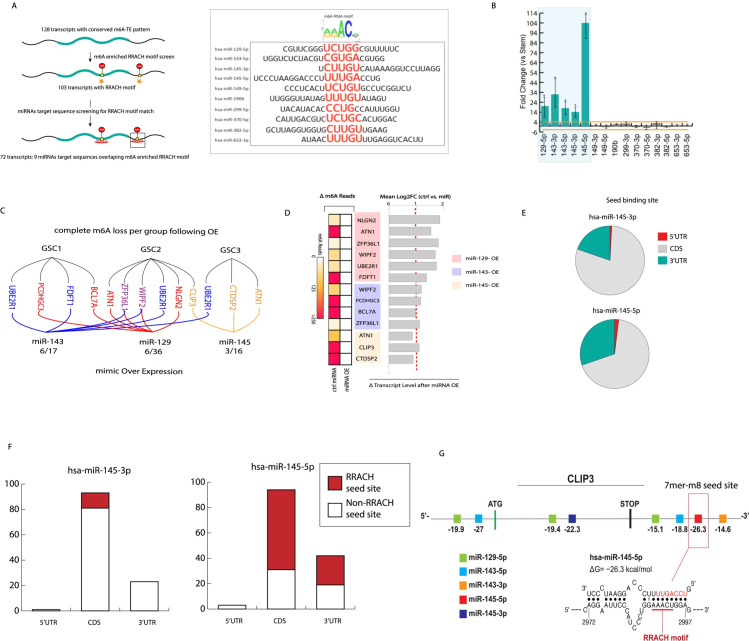
Ectopic expression of miRNAs predicted to bind within m6A enriched RRACH motifs results in target transcript demethylation without corresponding downregulation.A) Schematic of the identification process for the 9 miRNAs that are complementary to m6A enriched RRACH motifs. The 72 target transcripts have lost methylation and increased TE during cellular transition across all samples. B) qPCR of all 9 candidate miRNAs. Fold change represents the difference in miRNAs expression between GSCs and differentiated progenies (used fold change of 4 for significance cut-off). C) Ectopically expressed miRNA mimics in respective GSCs and their target transcripts. D) Transcripts methylation and expression status following over expression of miRNA mimics. E) Predicted fraction of miRNA 145-3p and 5p seed binding sites by transcript regions. All binding sites are from sets of 72 transcripts targeted by miRNA 145 (145-3p: 1 site in 5’UTR/ 93 sites in CDS/23 sites in 3’UTR; 145-5p: 3 sites in 5’UTR/ 94 sites in CDS/ 42 sites in 3’UTR). Predictions from human V-Clip based S fold. F) Illustrates fractions of miRNA 145 seed sites predicted to bind within RRACH motifs over all predicted seed binding sites. (145-3p: (0/1) site at 5’UTR/ (12/94) or 13% of sites at CDS/(0/23) at 3’UTR; 145-5p: (0/3) sites at 5’UTR/ (63/94) or 67% of sites at CDS/(23/42) or 55% of sites at 5’UTR). G) S fold derived depiction of predicted binding sites of miRNA 143–145 cluster and miRNA 129-5p on CLIP3 transcript.